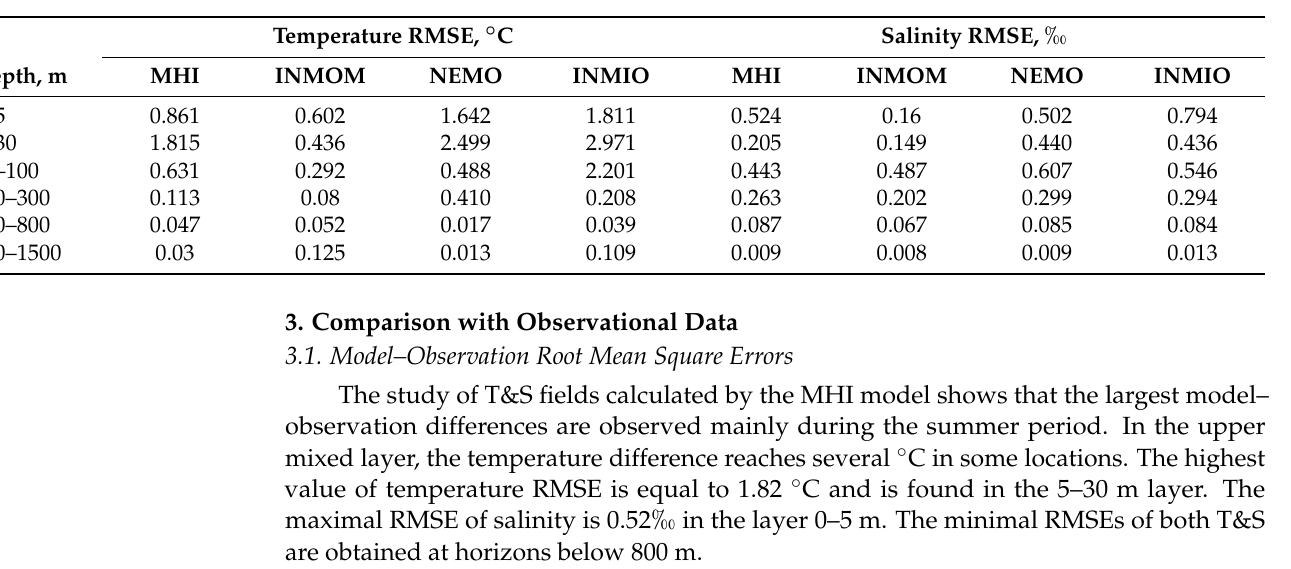
Table 2. Model–observation RMSEs of temperature and salinity for models and depth